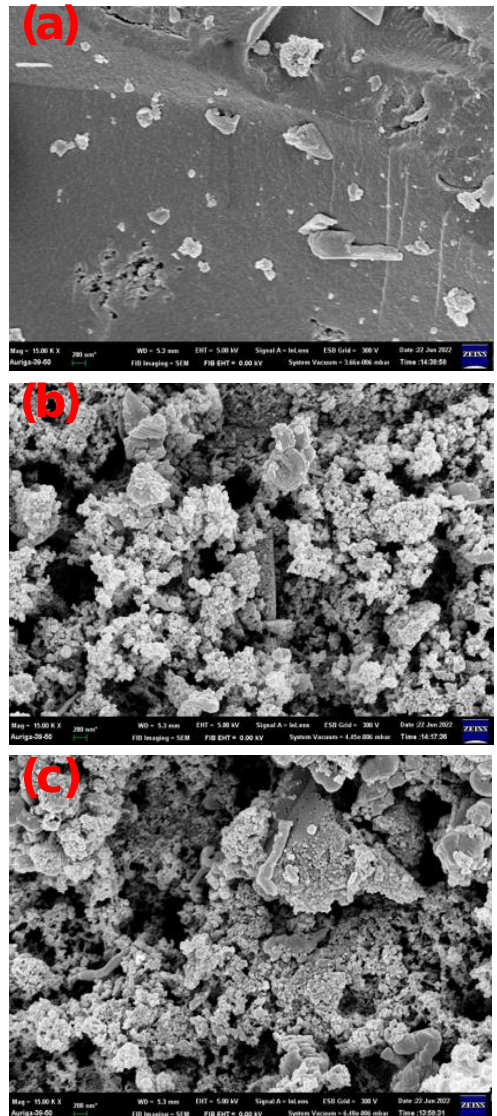
Figure 2. SEM micropictures of ( a ) CoNC-900A800 ( b ) CoNC-800A700 ( c )